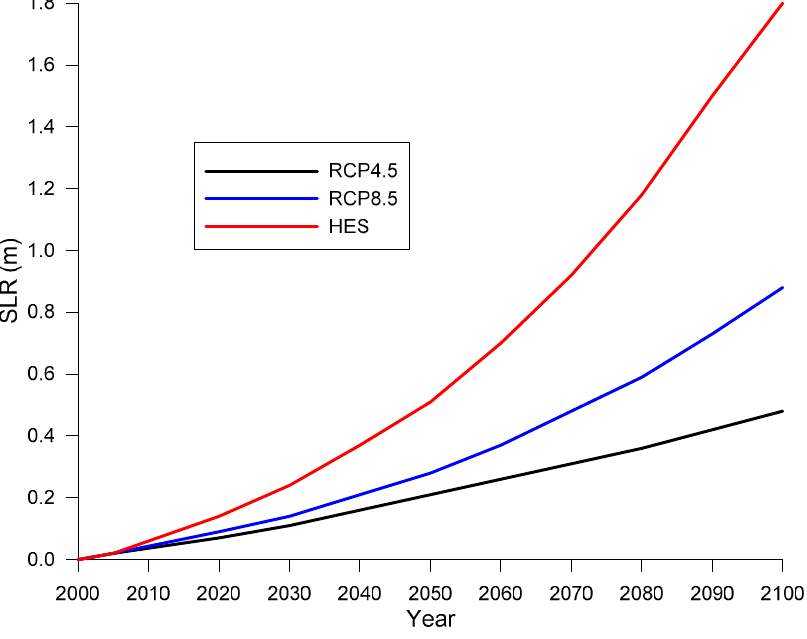
Figure 2. Evolution of sea level rise (SLR) during the 21st century for the three scenarios considered.